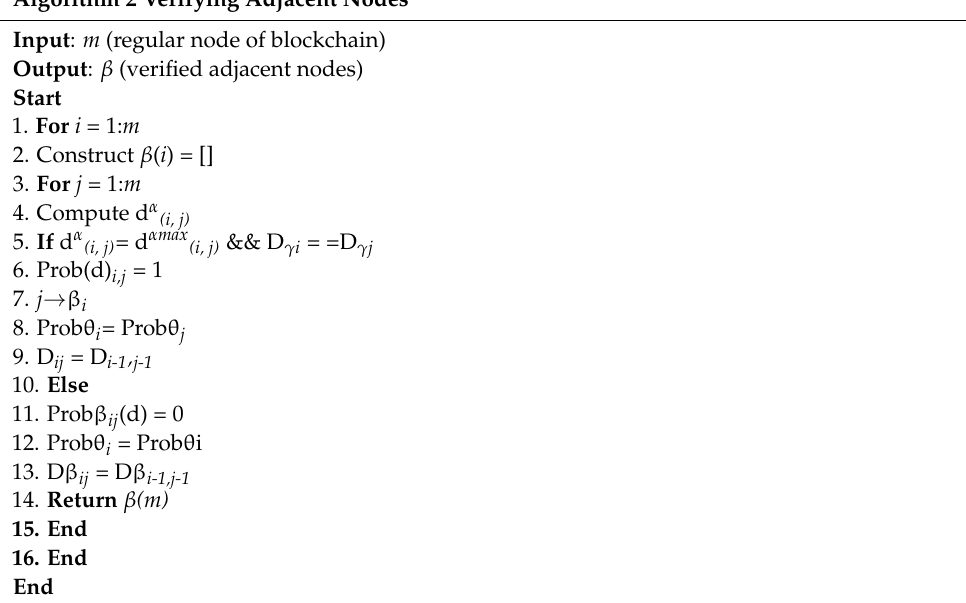
Algorithm 2 Verifying Adjacent